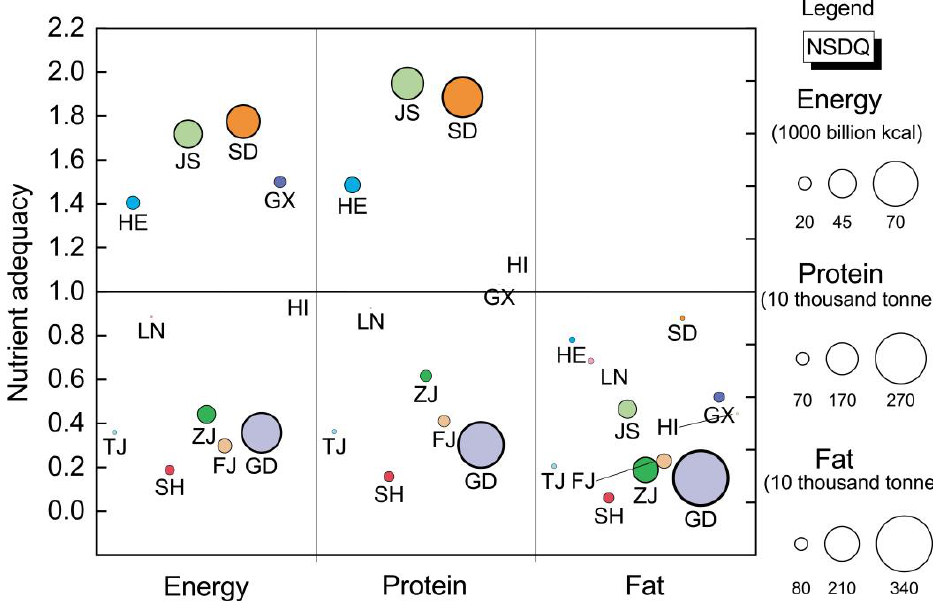
Figure 3. Spatial differences of nutrient adequacy in coastal areas of China.